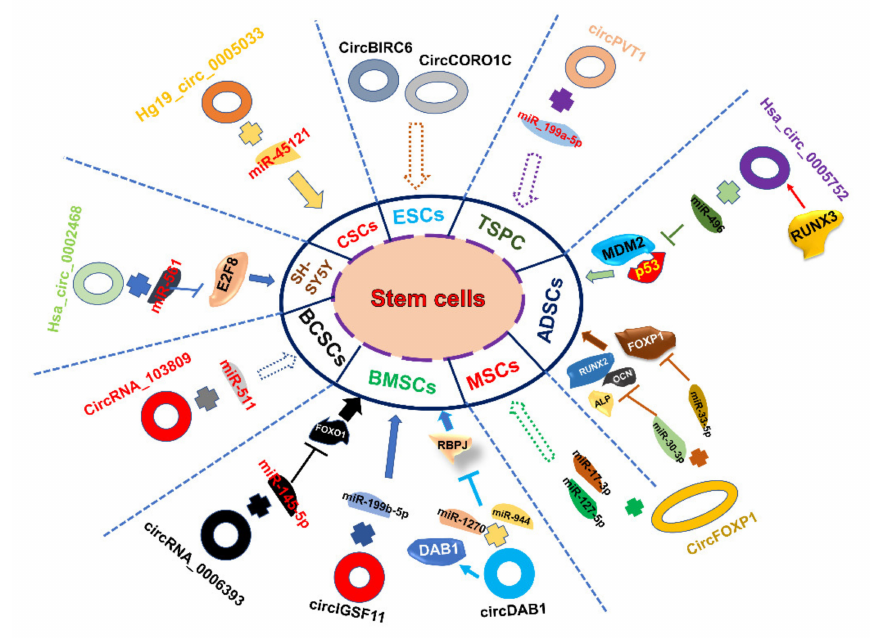
Figure 2. Schematic diagram of the roles and regulatory pathways of partial stem cell-associated circular RNAs. In ESCs, circRNAs (e.g., CircCORO1C, CircBIRC6) regulate the differentiation and pluripotency of hESCs. In TSPC, circPVT1 sponges miR-199a-5p to inhibit TSPC senescence. In ADSCs, hsa_circ_0005752 derived from the RUNX3 gene promotes the osteogenic differentiation of adipose-derived stem cells through binding with miR-496 and then releases the limit of MDM2-p53. CicrFOXP1 can bind with different miRNAs and then regulate the downstream target genes of miRNAs both in ADSCs and MSCs. In BMSCs, circDAB1 (derived from DAB1 gene)/miR-944 and miR-1270/RBPJ axis, circIGSF11/miR-199b-5p and circRNA_0006393/miR-145-5p/FOXO1 axis play essential roles in BMSCs. hsa_circ_0002468/miR-561/E2F8 axis regulates SH-SY5Y differentiation and proliferation. circRNA_103809/miR-511 and hg_circ_0005033/miR-45121 facilitates the migration and invasion of BCSCs and